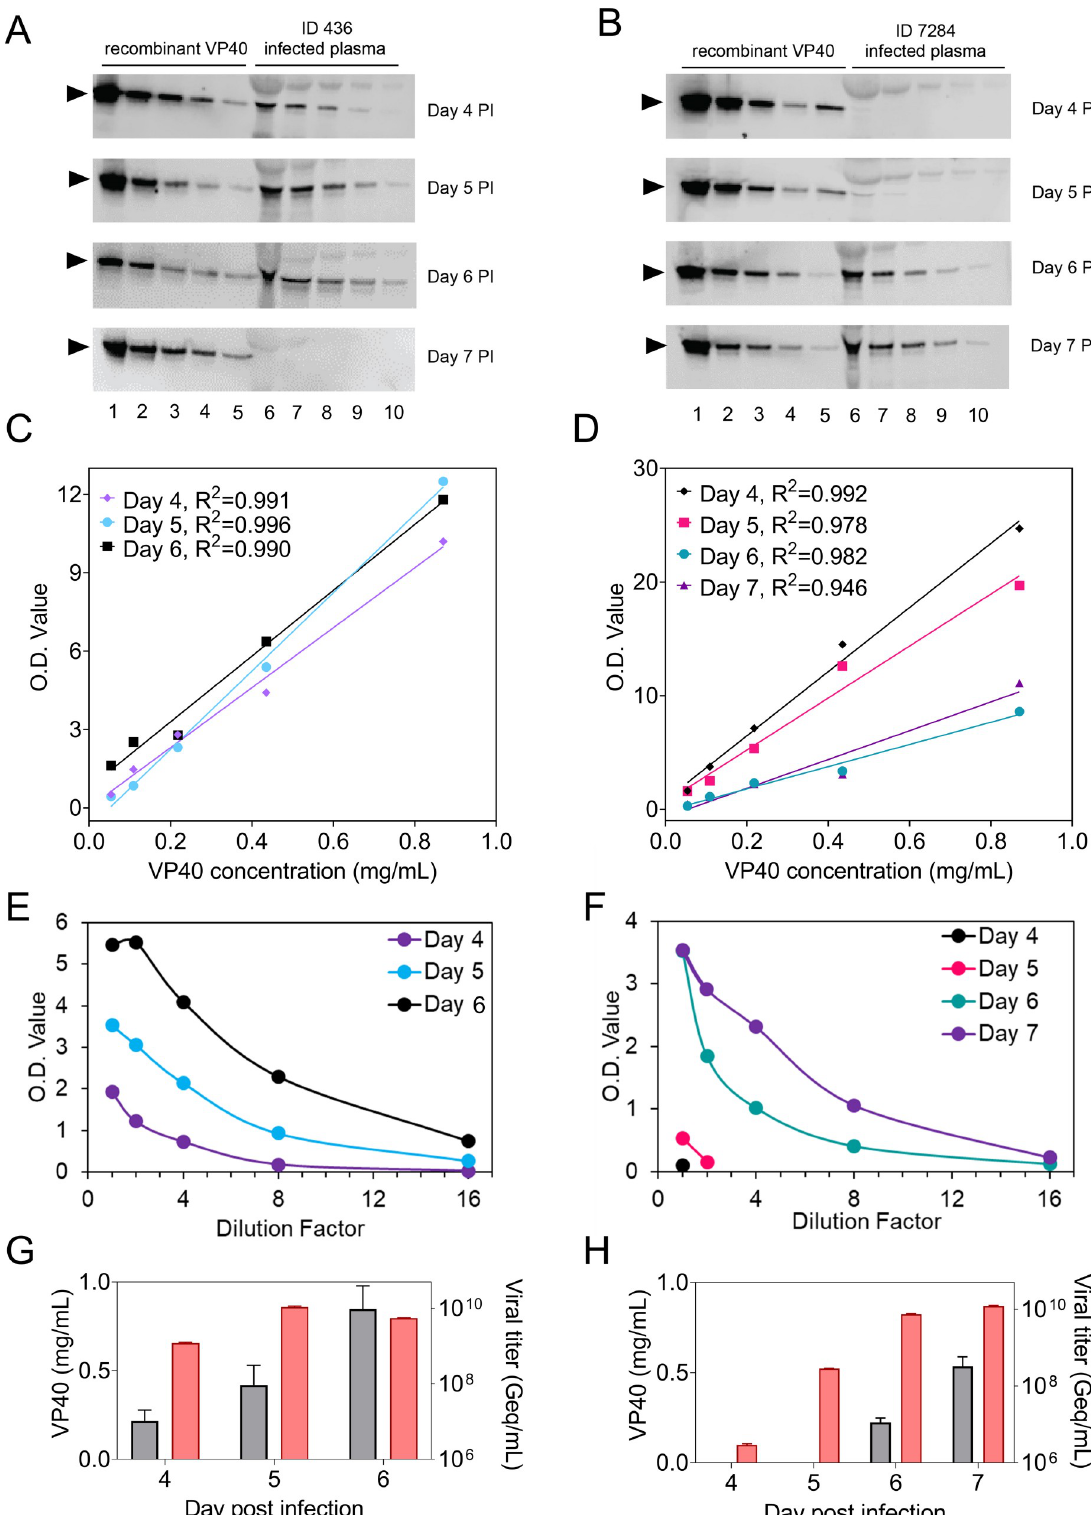
Fig 7. Western blot analysis of VP40 in NHP plasma with longitudinal collections. (A-B) A concentration gradient of recombinant VP40 is used as standard, and serial dilution of NHP plasma post-infection (PI) is measured on the same membrane. Well 1–5